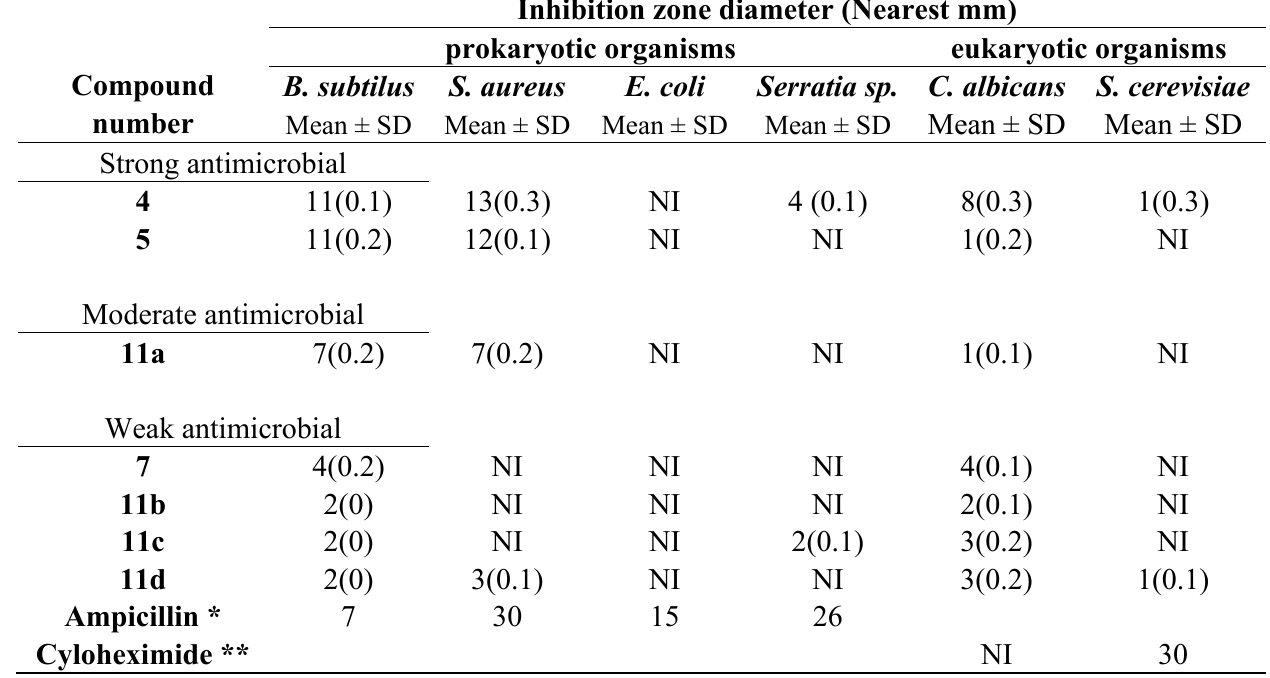
Table 4. Diameter of the zones of inhibition of the tested compounds that showed weak to strong antimicrobial against